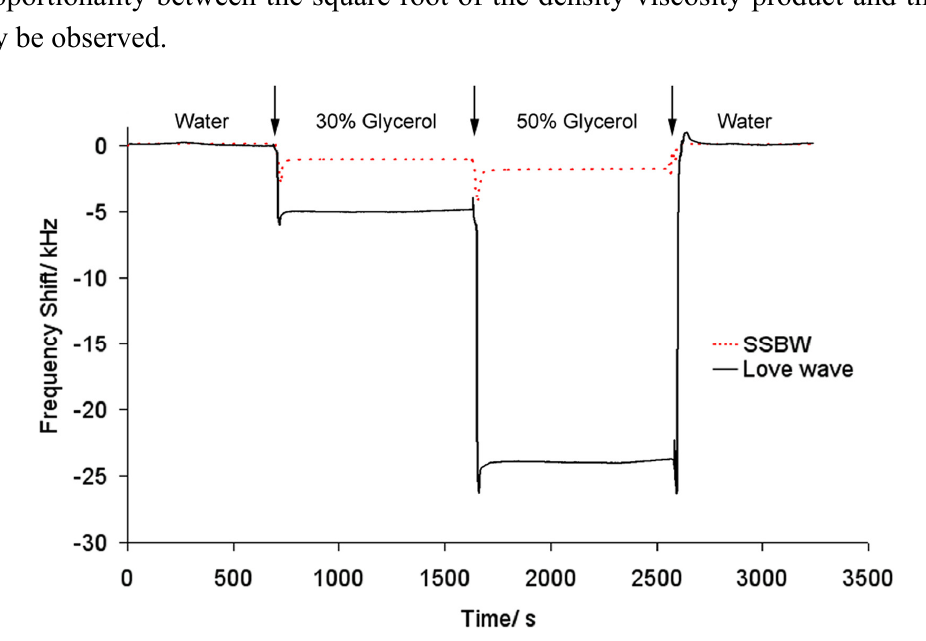
Figure 4 . Liquid sensing of an SSBW device (dotted red line) and a Love wave device with an SU-8 guiding layer (solid black line), using water-glycerol mixtures. Arrows indicate points when liquid in contact with the sensor was